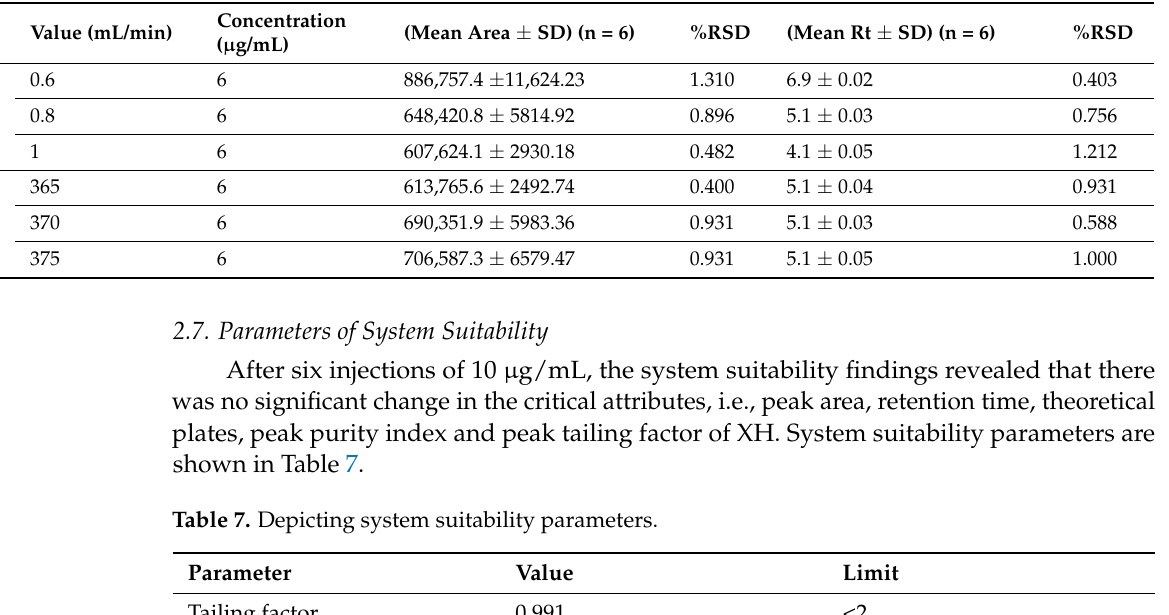
Table 6. Represented Robustness data of the method.